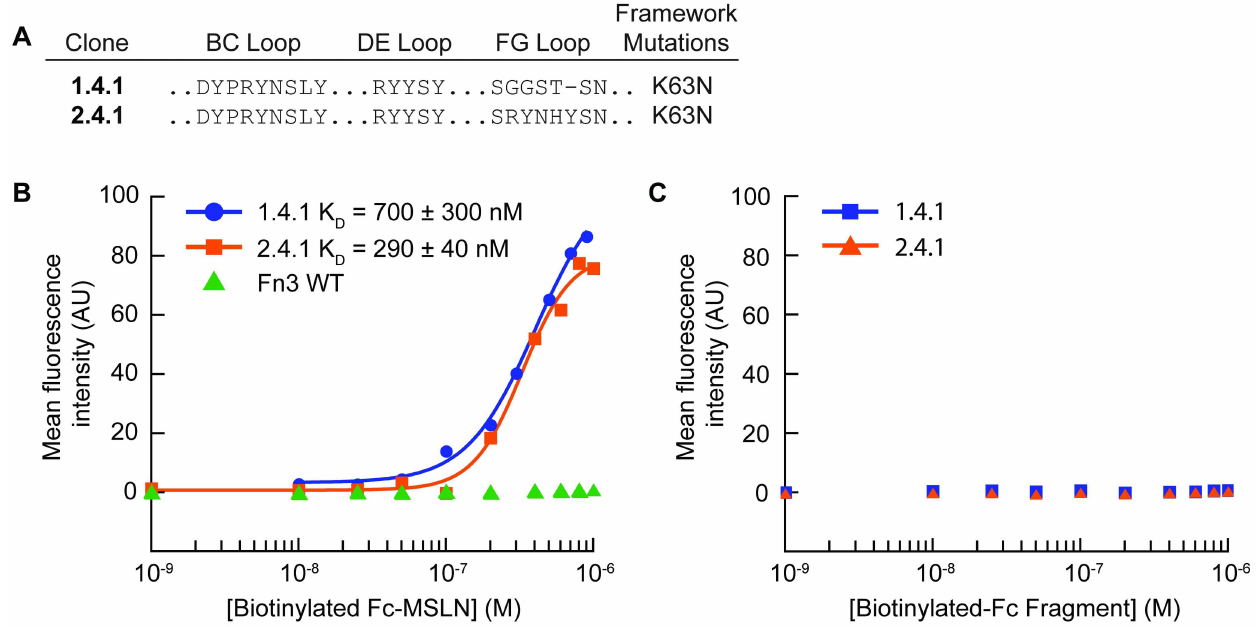
Fig 3. Yeast displayed Fn3 variants 1.4.1 and 2.4.1 bound specifically to tumor biomarker MSLN. (A) Two dominant Fn3 variants, 1.4.1 and 2.4.1, were recovered from a first generation and second generation Fn3 library, respectively. (B) Individual clones and Fn3 WT were displayed on the surface of yeast and incubated with a range of concentrations of soluble MSLN. Experimental triplicate data were collected, and the dissociation constant is reported as the mean and standard deviation of the K D values calculated for each replicate. A representative binding curve is shown for each variant. (C) Individual clones were displayed on the surface of yeast and incubated with a range of concentrations of a biotinylated, Fc fragment. Experimental triplicate data were collected. A representative curve is shown for each variant.